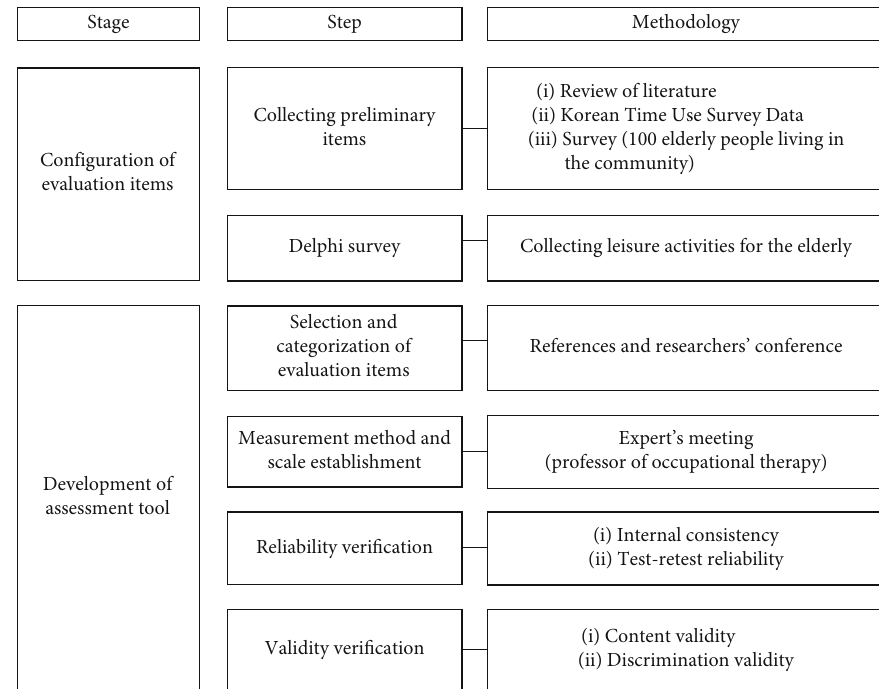
Figure 1: The development process of the leisure participation assessment tool for the